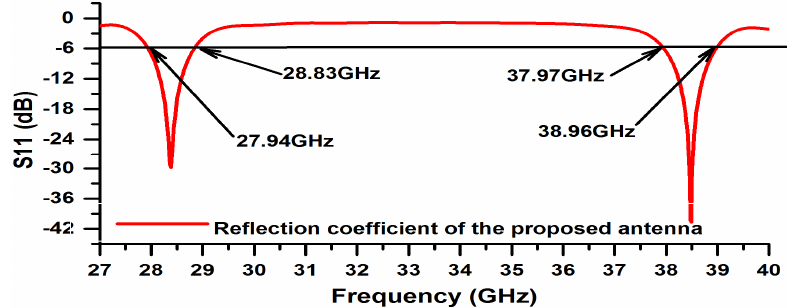
Figure 4. The reflection coefficient of the antenna.